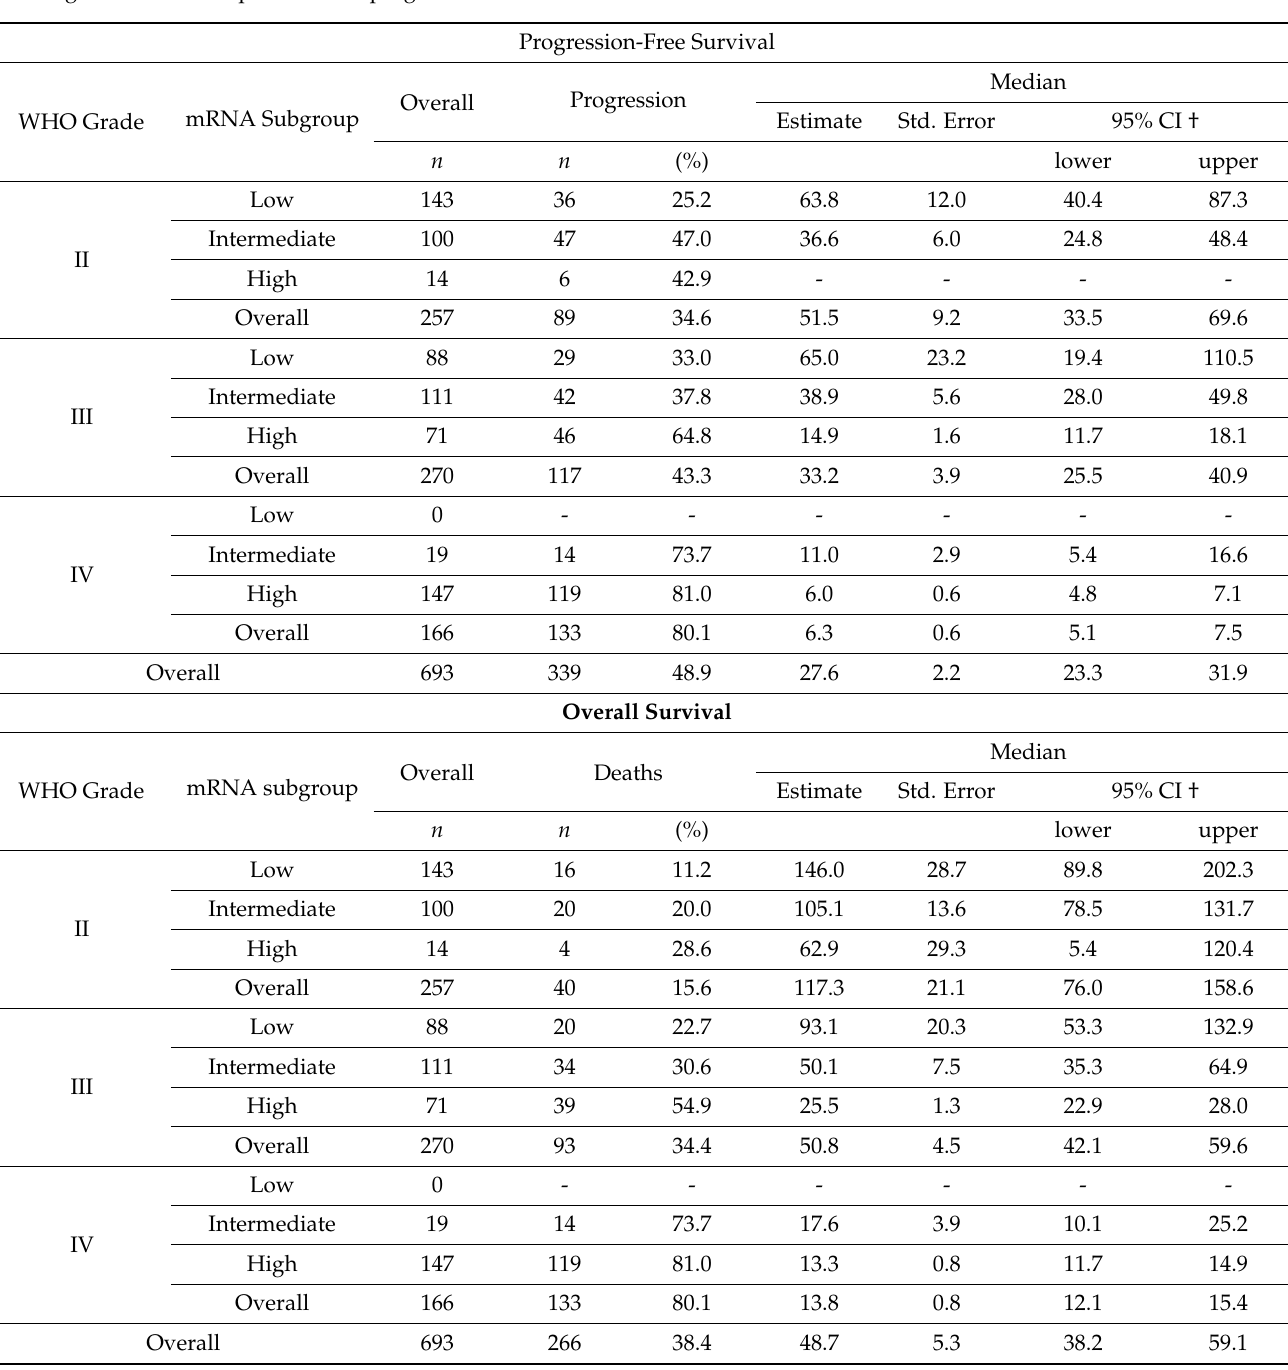
Methods section. According to our multivariate analysis, the mRNA expression signature significantly correlated with both progression-free survival as well as overall survival after correcting for the WHO tumor grade, tumor subtype, age, and sex ( p < 0.0005). Survival curves for the Cox model for progression-free and overall survival are given in Figure 3. In order to verify that our results demonstrate a genuine prognostic impact rather than an artifact due to the arbitrarily defined subgroups, Cox regression results were verified using the continuous mRNA expression signature variable and the p -values of p < 0.0005 were confirmed. Table 2. Survival data. The exact case numbers and survival times underlying the Kaplan–Meier curves shown in Figures 1 and 2 are provided for progression-free and overall survival. Progression-Free